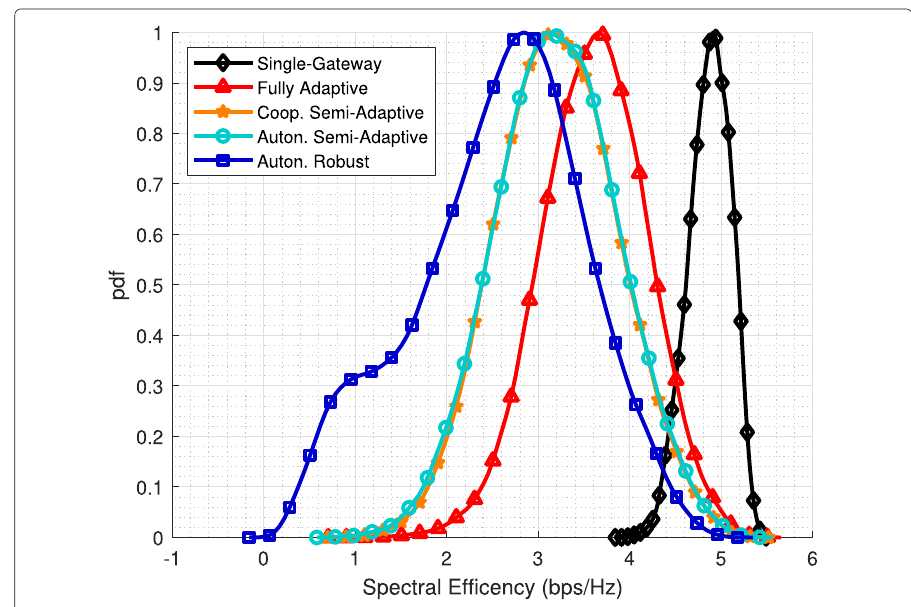
Fig. 15 Spectral efficiency pdfs for 3 users per frame. SNR = 20